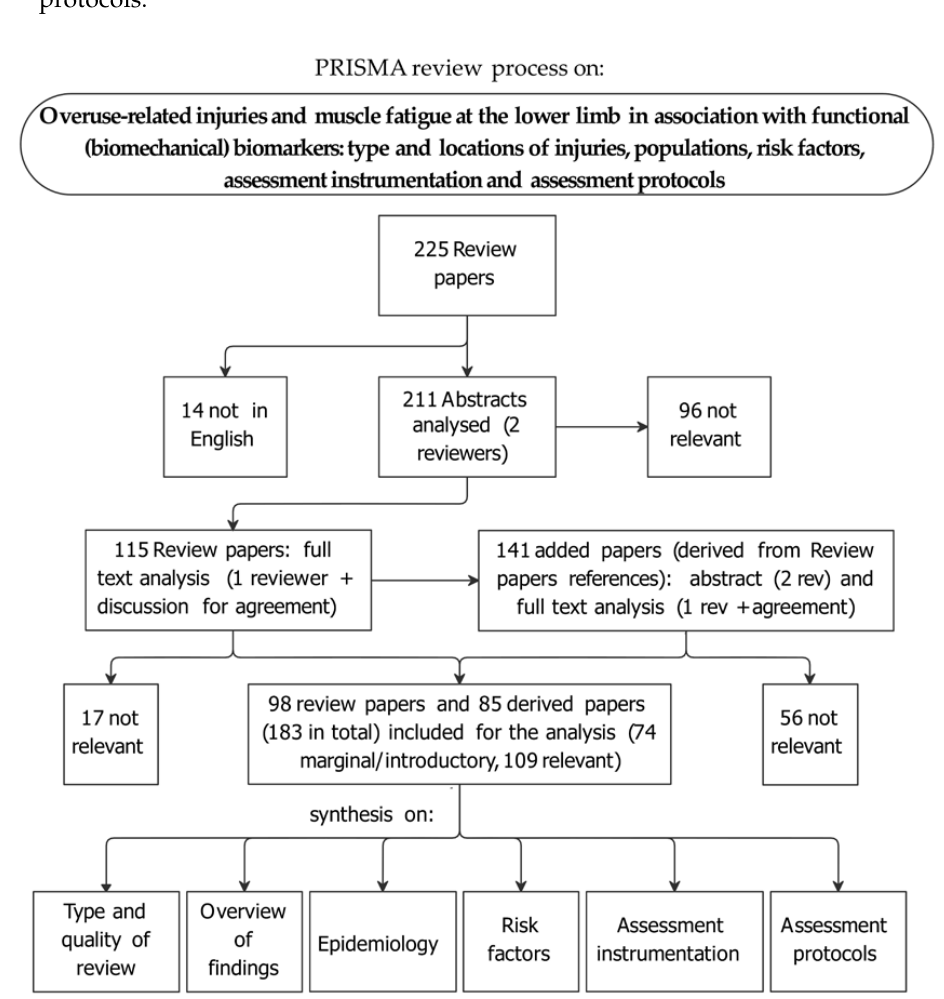
Figure 1. Flowchart of the review process based on PRISMA guidelines for systematic reviews